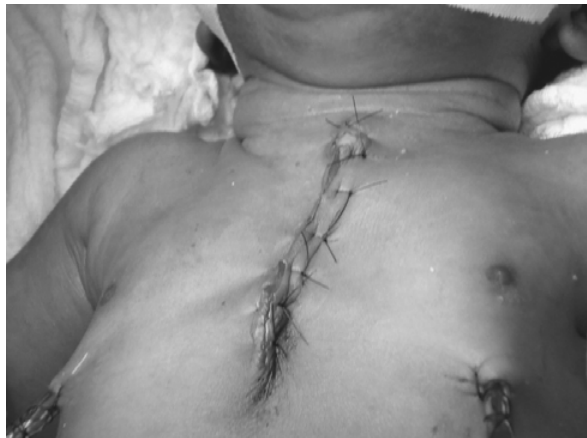
Fig. 2 - Paciente após intervenção cirúrgica, com incisão mediana e ressecção do tecido